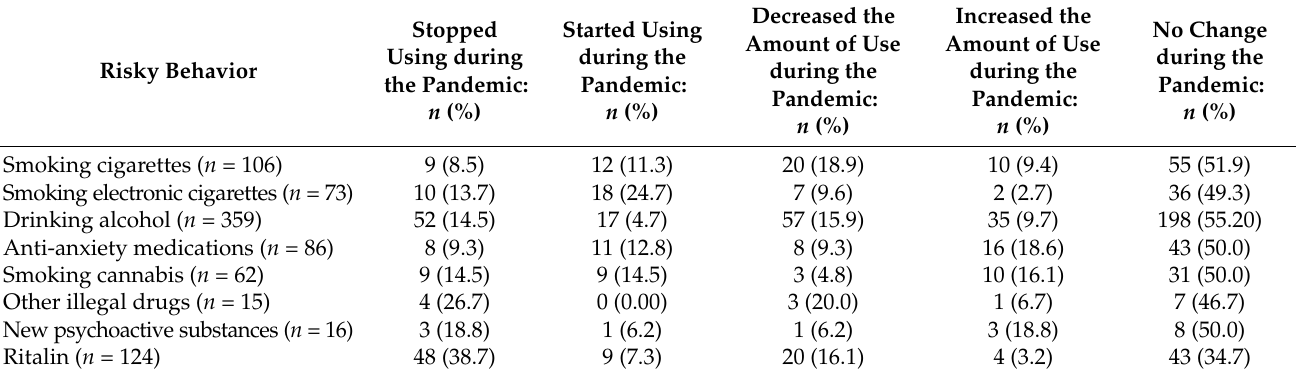
Table 4. Changes in risky behavior during the pandemic among users.